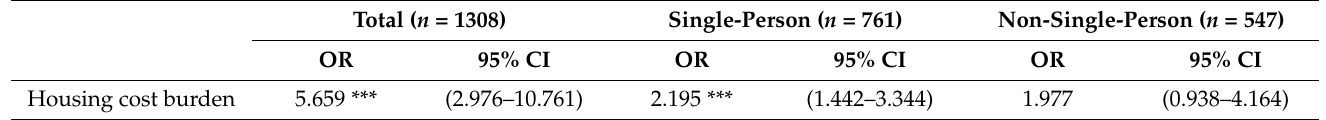
Table 4. Association between housing cost burden and material hardship. Total ( n = 1308) Single-Person ( n = 761) OR